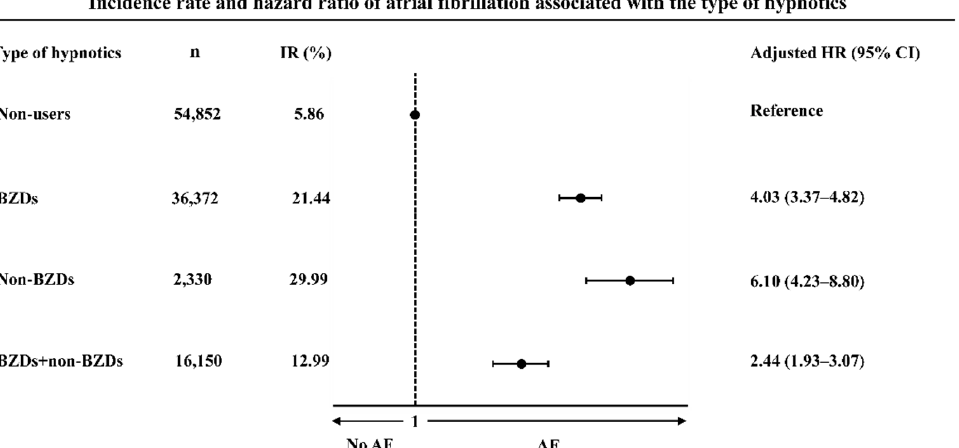
Table 2. Stratified analyses of the comparisons with non-hypnotics users for the incident atrial fi- brillation in hypnotics users.